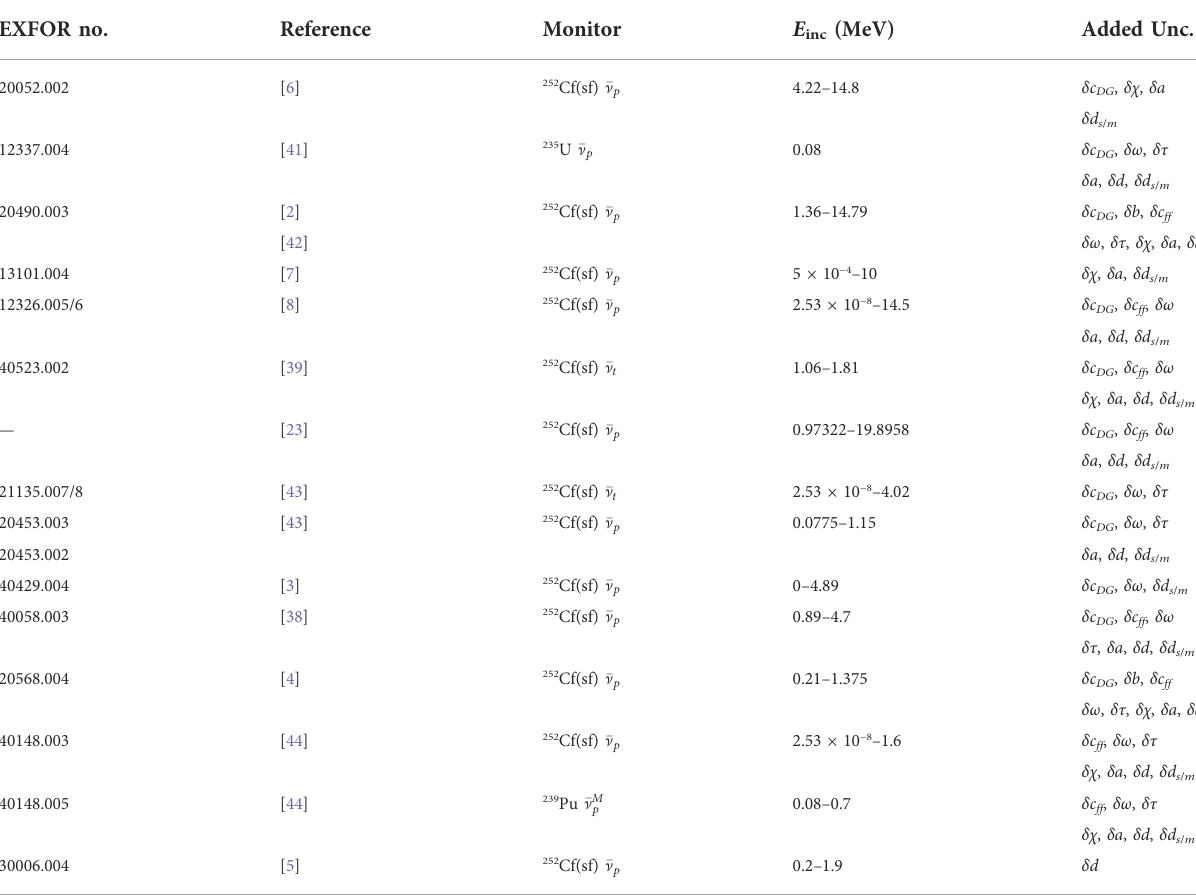
TABLE1Experimental 239 Pu (cid:1) ] p includedintheevaluationarelistedwiththeirEXFORNo., fi rstauthor,yearofpublication,mainreferenceand E inc .The last column tabulates uncertainty sources that were added to those found in the literature. The variable names de fi ne the following uncertainty sources: δ c DG fordelayed γ rays, δχ and δ a forPFNS andangulardistributionof fi ssionneutrons corrections, δ d s / m for sampledisplacement, δω and δ b for correcting impurities and random background, δτ for deadtime, δ d for sample thickness, and δ c ff for false fi ssion corrections. EXFOR